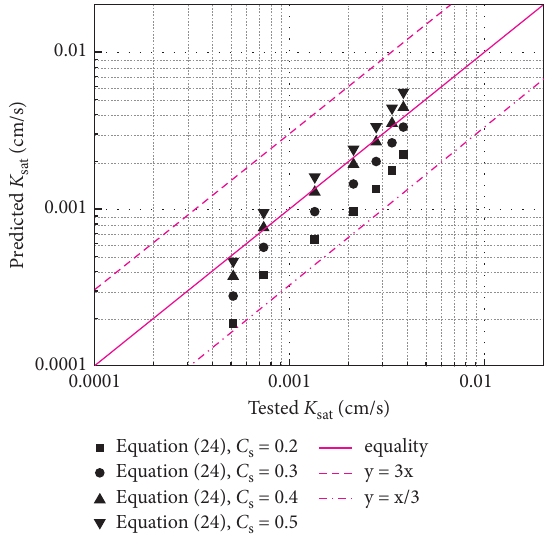
Figure 8: Predicted versus tested K shape coefficient C s .